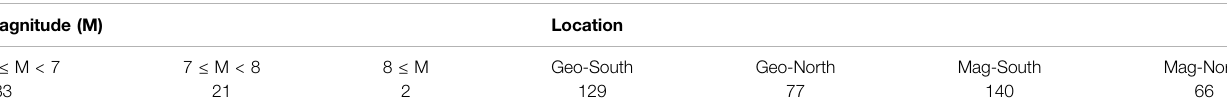
TABLE 1 | Summarized information of 206 Mw ≥ 6.0 earthquakes. Magnitude